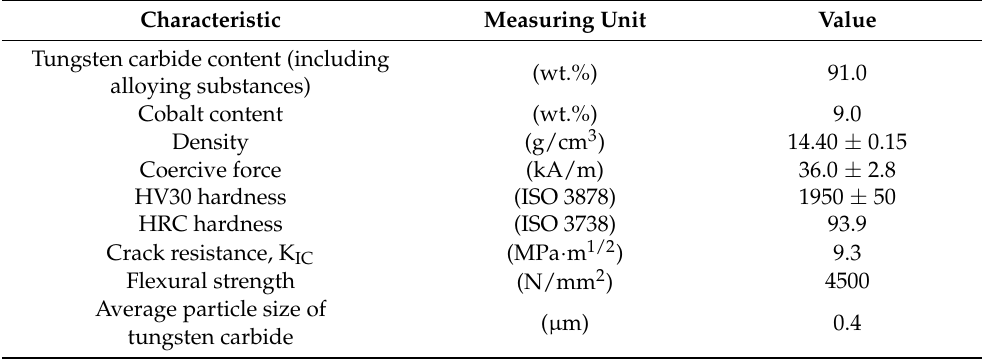
Table 1. Characteristics of KFM 39 cemented